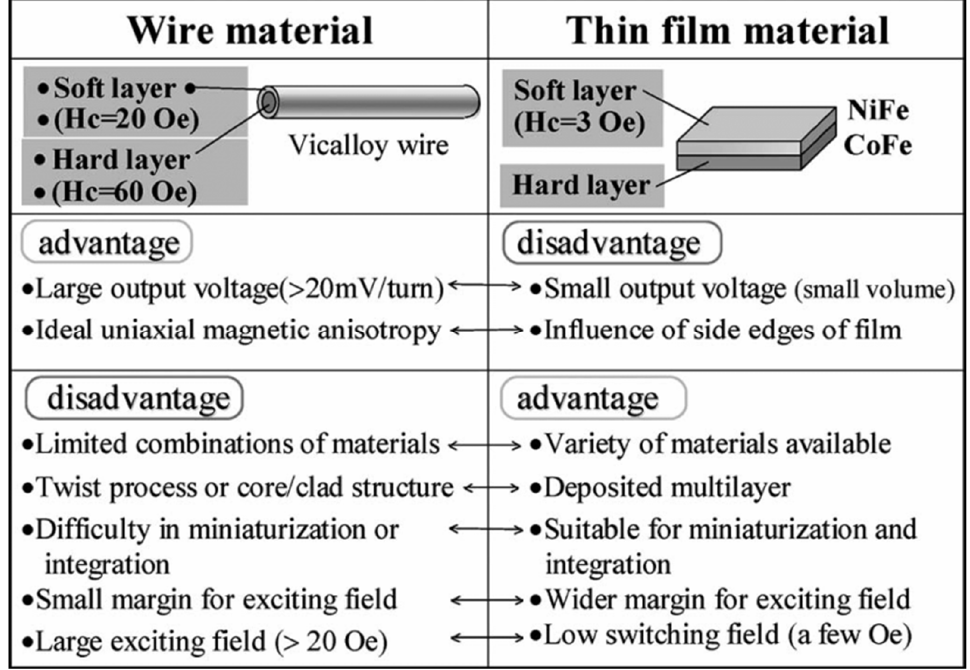
Figure 2. Comparison of core/shell wire and film/substrate multilayered Wiegand sensors. © 2006 IEEE. Reprinted with permission from [27].